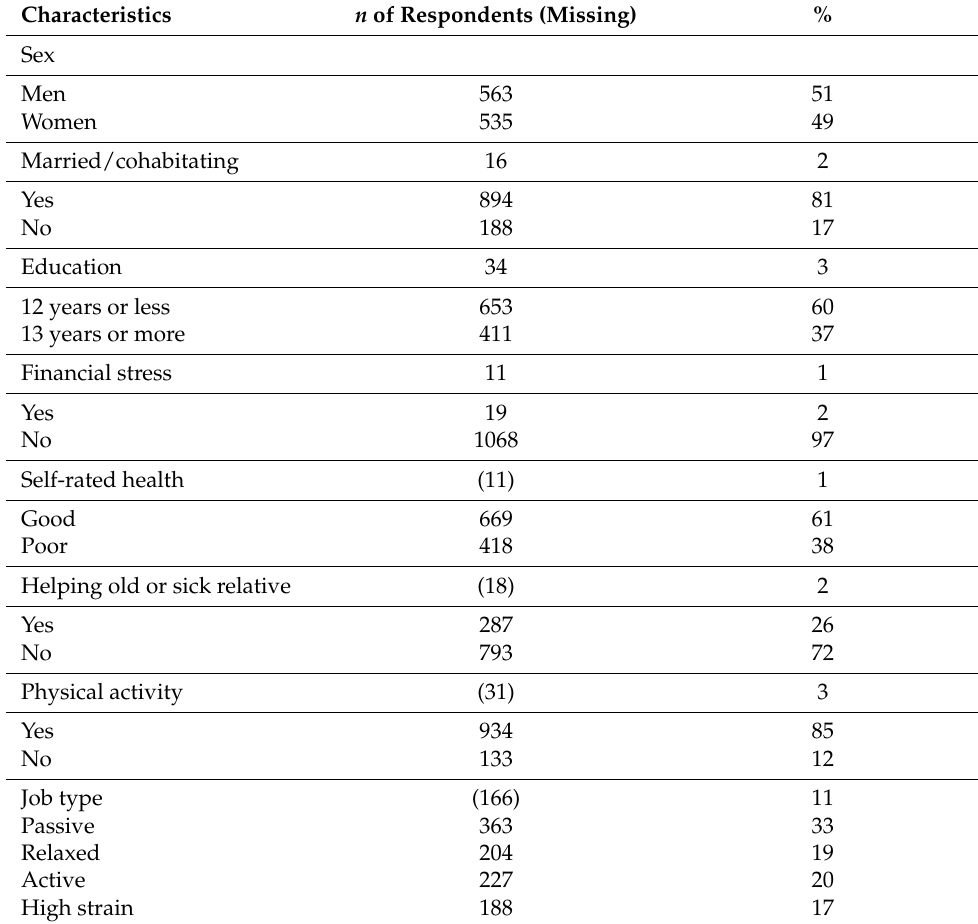
Table 1. Sociodemographic variables, and psychosocial working conditions at baseline, n = 1098. Characteristics